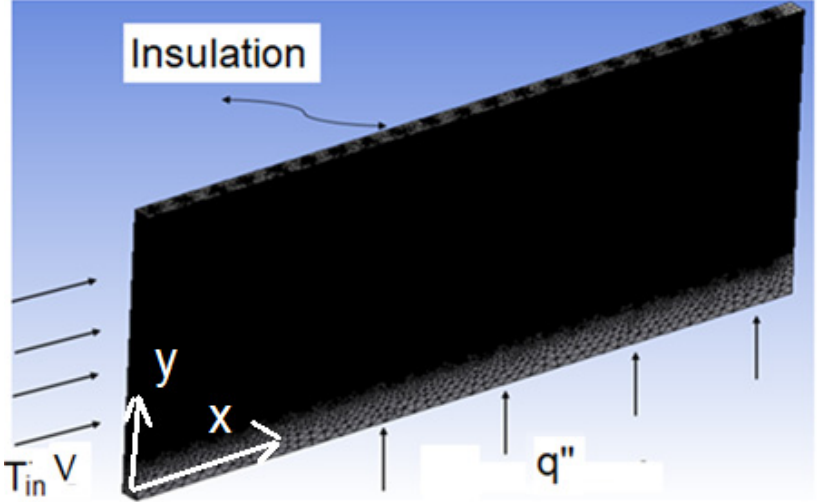
Figure 5. A representative section of the EPS model as a solution domain with meshing. The x- and y-coordinates are measured in mm, while the velocity V is measured in m/s, the inlet temperature T in in K, and the heat flux q” in W/m 2 .